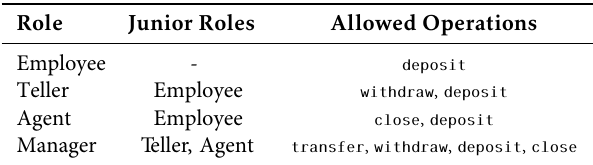
Table 2. A Sample RBACPolicy